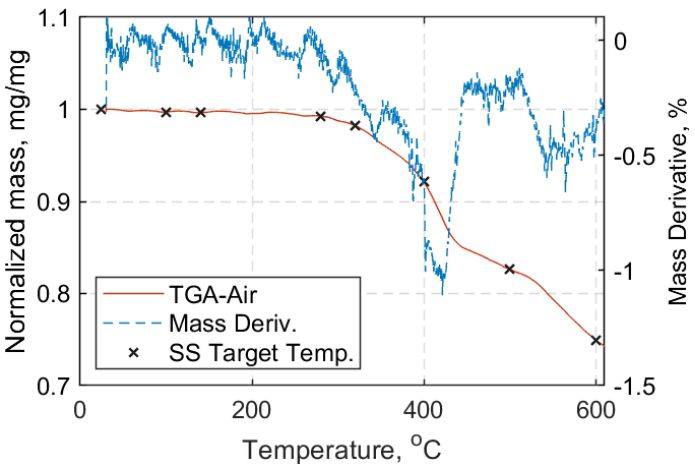
Figure 18. Representative thermogravimetric analysis (TGA) curve in air atmosphere for CFRP Straps with steady state (SS) target temperatures denoted.